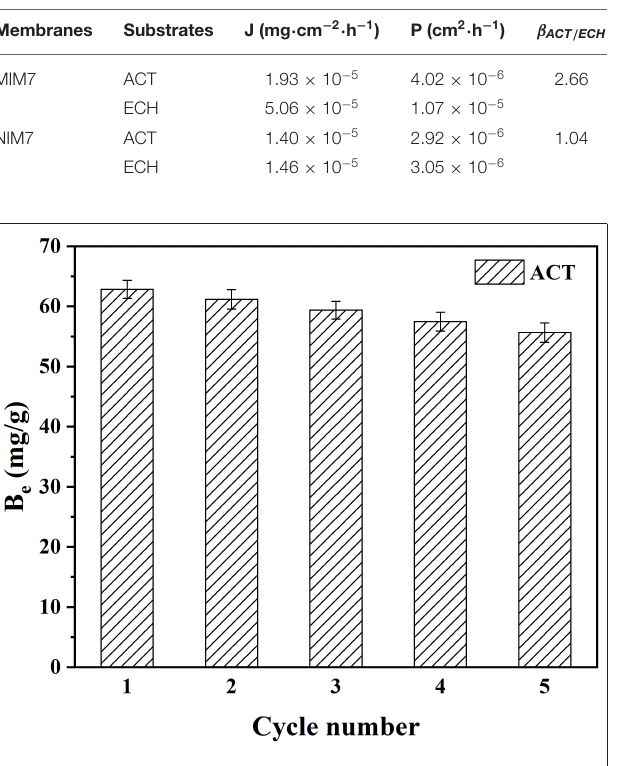
MIM7, and the ECH has passed smoothly. This indicates that delayed penetration plays a dominant role in the selective separation of MIM7. The separation efficiency of ACT mainly depends on the imprint holes of MIM7. In other words, this is because the presence of holes imprinted on the surface of MIM7 makes ACT molecules recombine with MIM7, while in ECH this does not occur (Wang et al.,